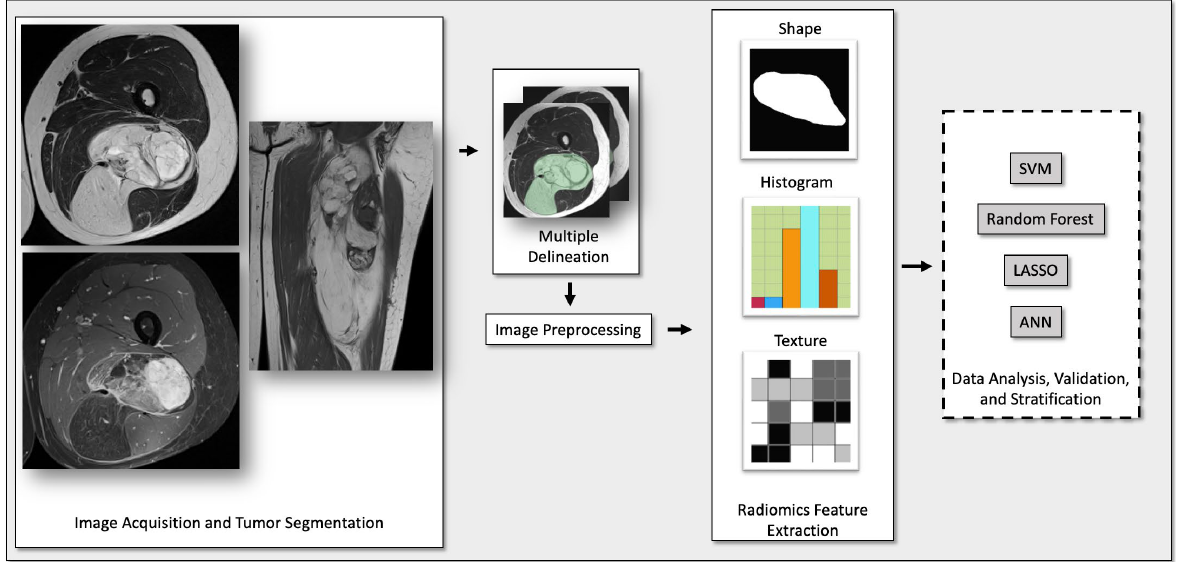
Figure 2. Radiomic workflow. Abbreviations: SVM, support vector machine; LASSO, least absolute shrinkage and selection operator; ANN, artificial neural network.